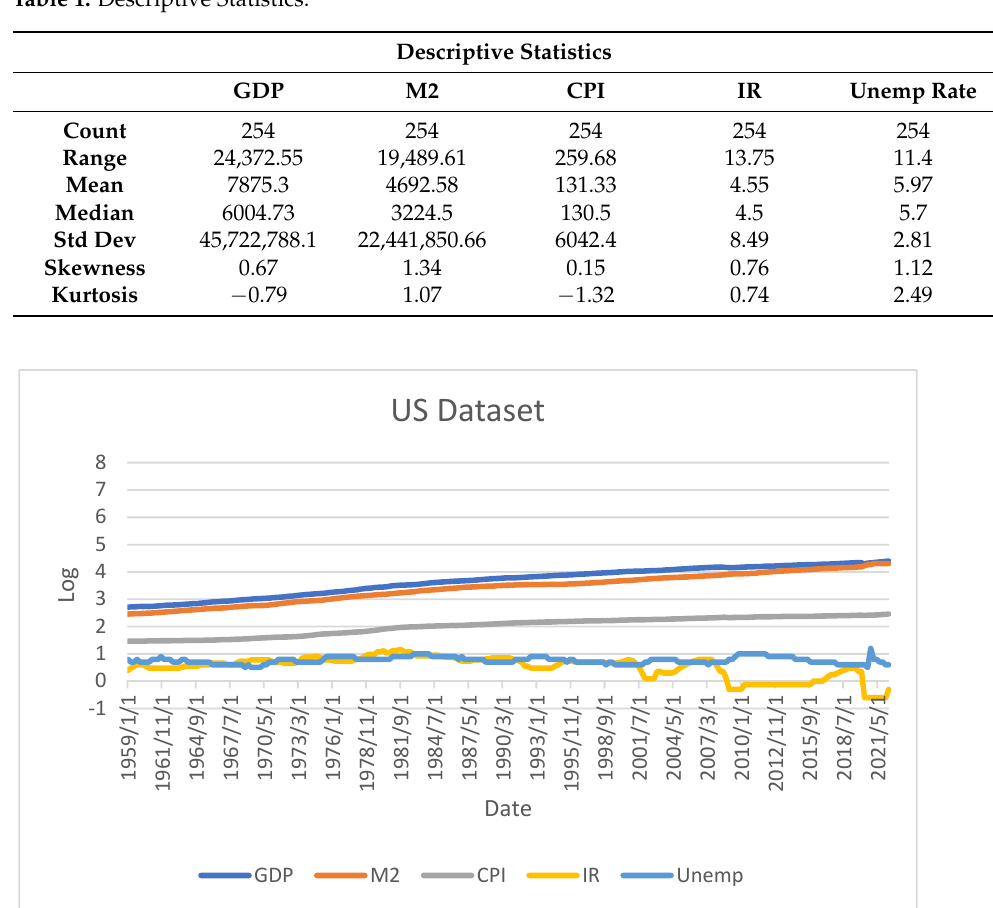
Figure 1. Macroeconomic variables in the log, over the examined period, 1959–2022.